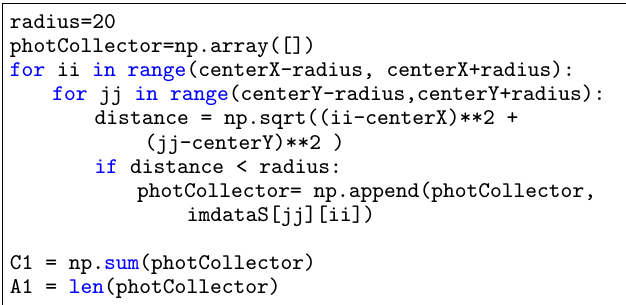
other words: those pixels that are in the circle we are interested in: radius=20